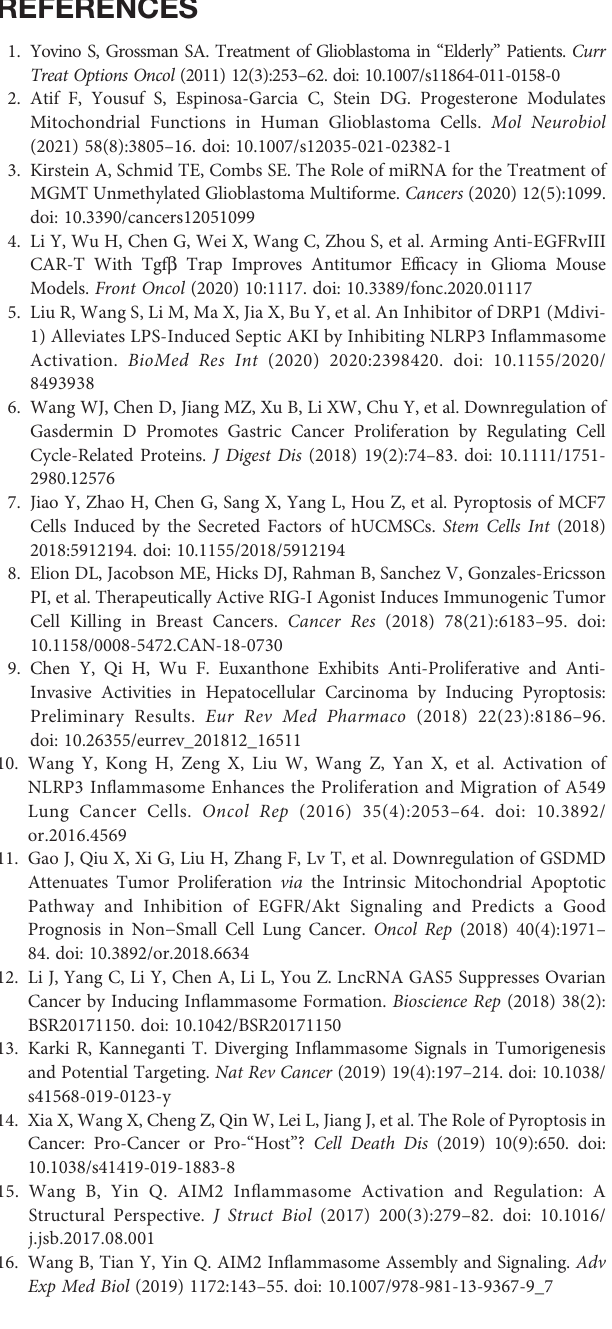
Supplementary Figure 1 | Processes of LASSO Cox model fi tting. (A) The pro fi le of coef fi cients in the model at varying levels of penalization plotted against the log (lambda) sequence. (B) Tenfold crossvalidated error ( fi rst vertical line equals the minimum error, whereas the second vertical line shows the crossvalidated error within 1 standard error of the minimum). Supplementary Table 1 | Thirty-three pyroptosis-related genes.